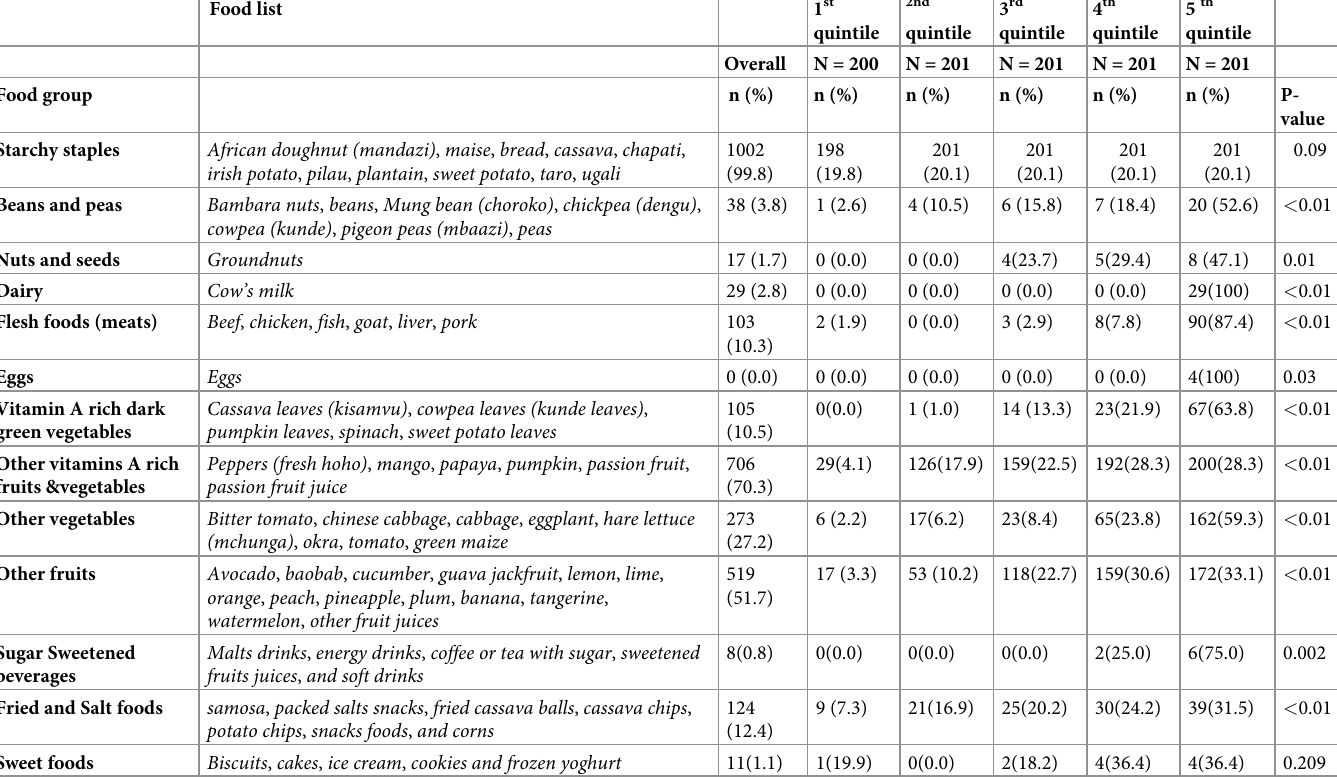
Table 2. Distribution of food groups consumed daily by quintile of Dietary Diversity Score (N = 1004). Food